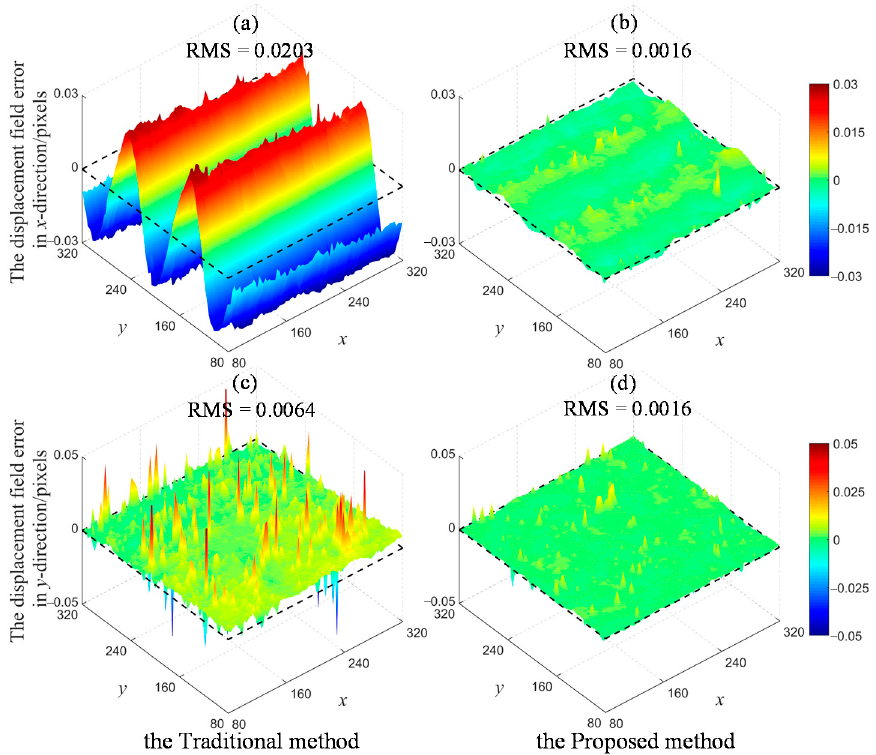
Figure 4. Full-field displacement errors of experiment 1 at 40 ◦ rotational angle for the large deforma- tion case: ( a ) The x -directional errors obtained by the traditional method; ( b ) The x -directional errors obtained by the proposed algorithm; ( c ) The y -directional errors obtained by the traditional method; ( d ) The y -directional errors obtained by the proposed algorithm.